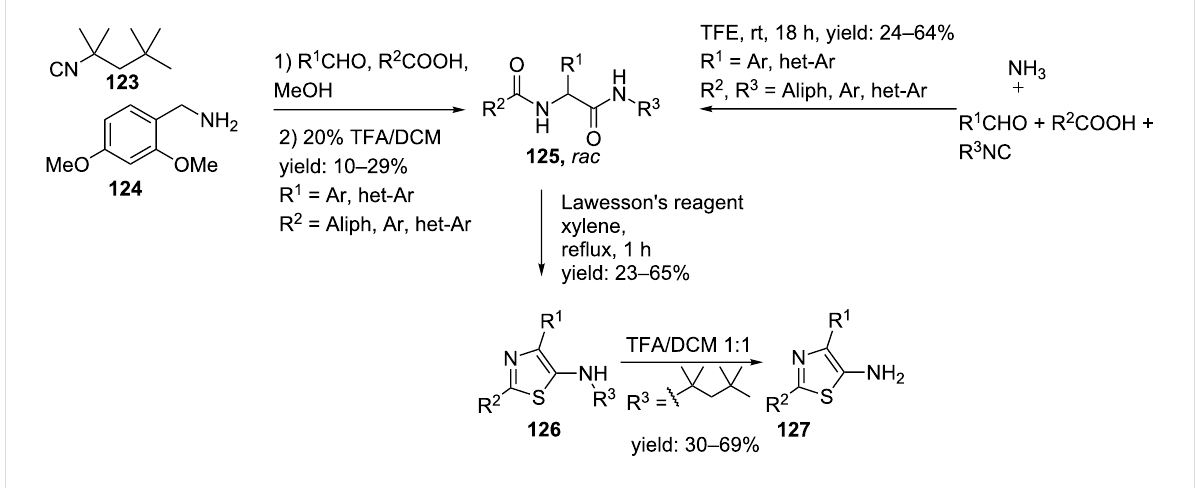
Scheme 38: The synthesis of the trisubstituted thiazoles could be either performed via an Ugi reaction with protected amines or with